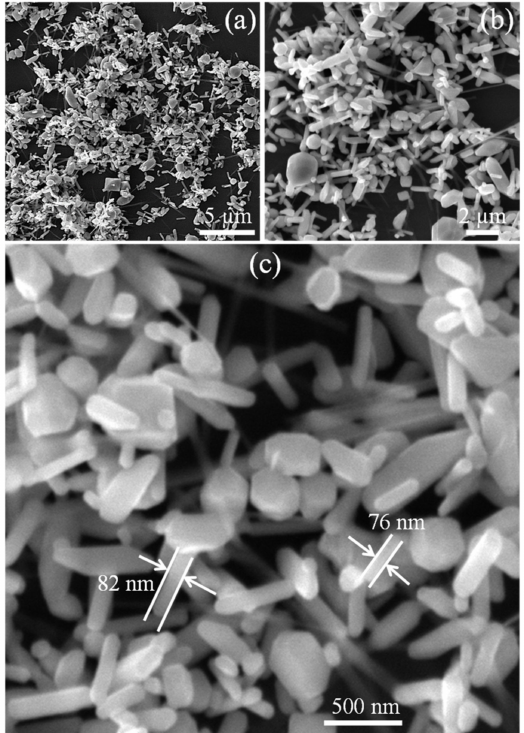
Figure 2. SEM images of TiO 2 at; ( a , b ) Low-magnification; ( c ) High-magnification.